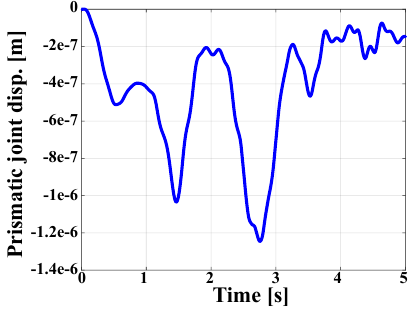
Figure 12. Displacement for the prismatic joint at point B . While the overall motion of the shell can be described as a rigid-body motion, the impulsive forces applied at point C , redistributed within the half-cylinder through BeamCD , generate time-dependent stress resultants in the shell. Figure 13a,b show the bending moment and transverse shear force components, respectively, at the center point of the half- cylinder. For time t ≤ 2 T = 4 s, large peaks are observed in the sectional stress resultants; for t > 4 s, the half cylinder continues its rigid-body rotation with superimposed, small- amplitude vibrations. Figure 14a,b show the forces and moments, respectively, at the mid- points of BeamAB and BeamCD . Because these beams share degrees of freedom with the shell, forces and moments are transferred seamlessly between the two structural components.